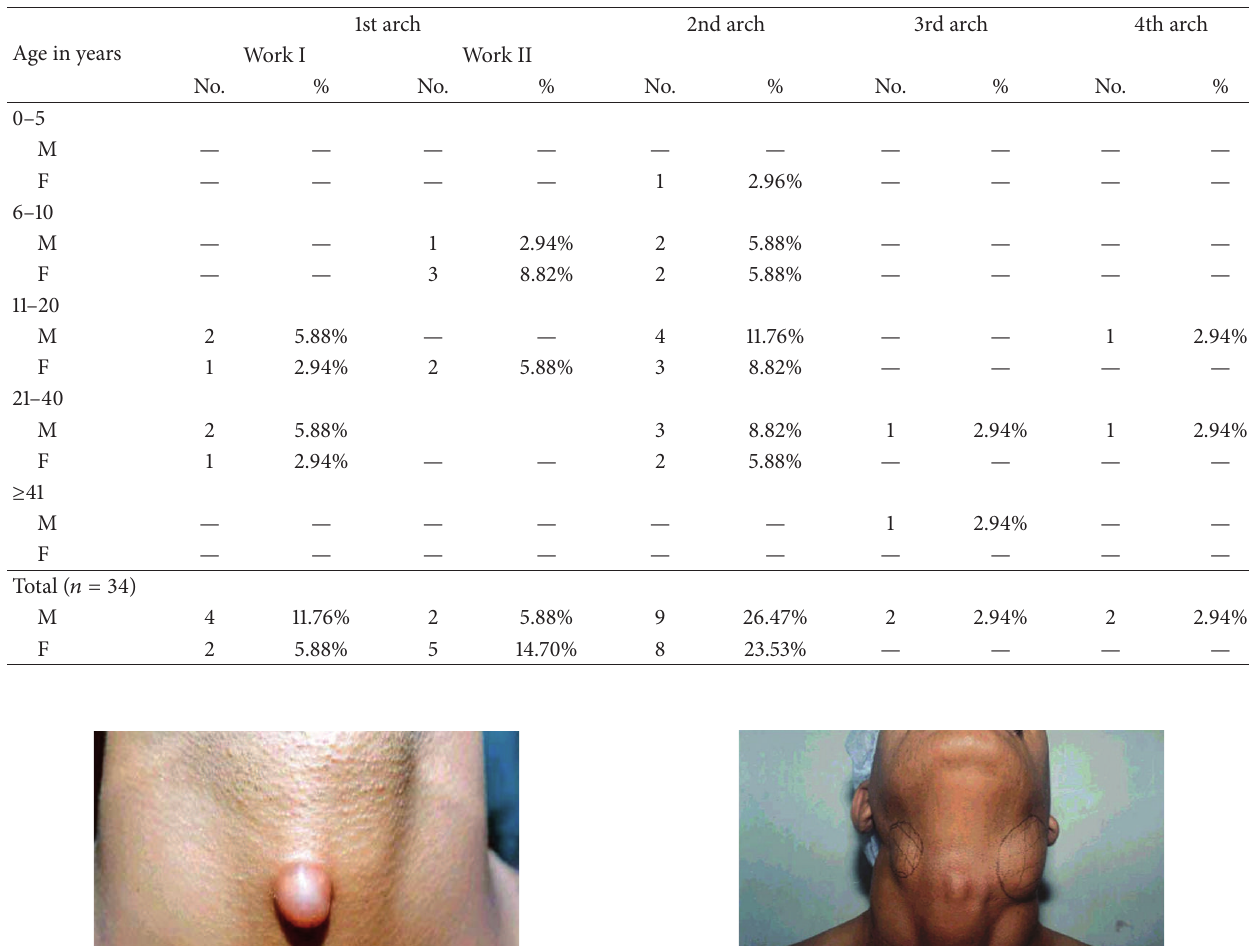
Table 2: Age and sex incidence.